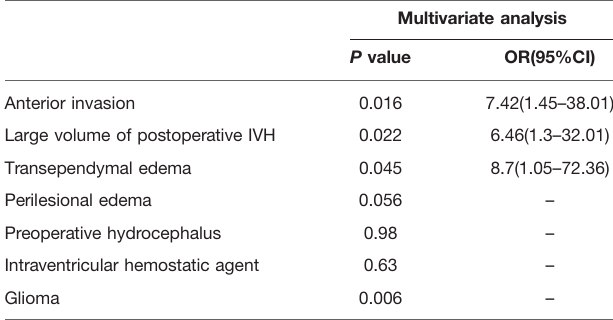
TABLE 3 | Multivariate analysis of the association between factors and postoperative acute hydrocephalus required CSF drainage by